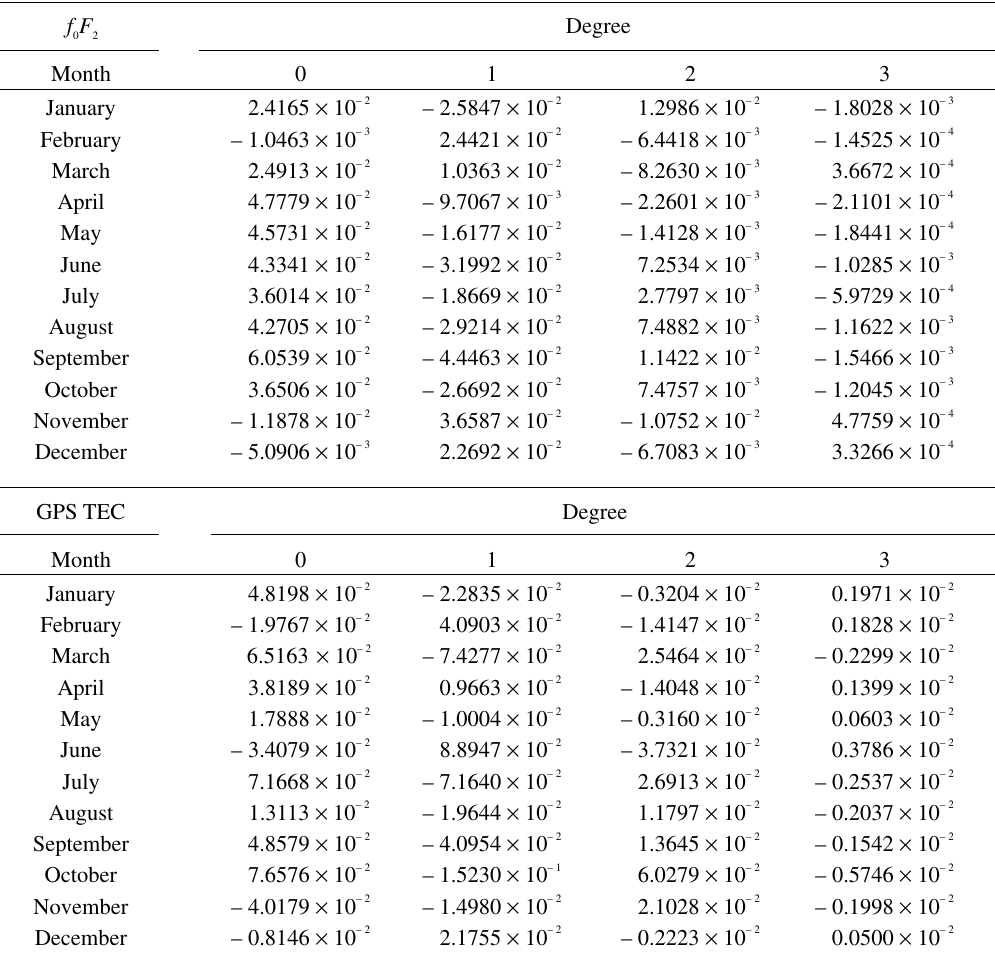
Table IV. Coefficients for the 3 –rd degree polynomial approximation of the average monthly response to geomagnetic activity; based on